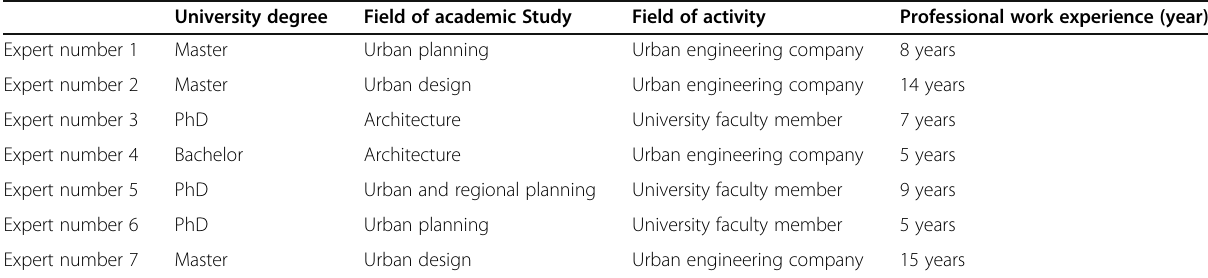
Table 7 Introducing the characteristics of experts and their field of